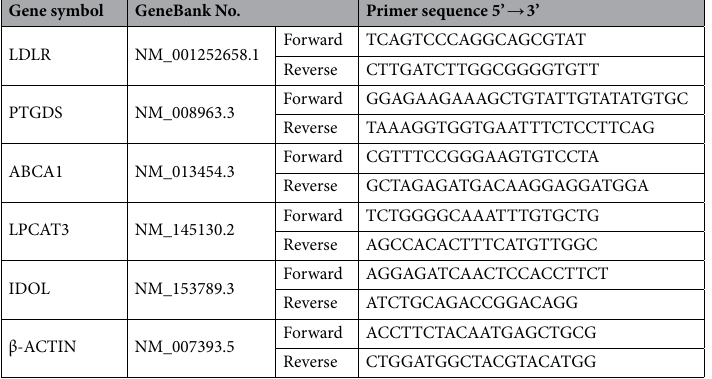
Table 1. qPCR primer